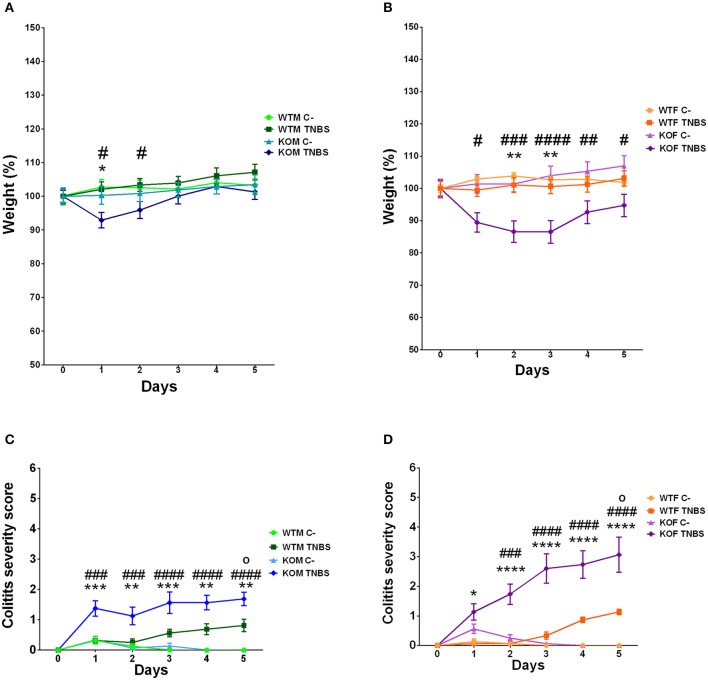
Body weight evolution and clinical assessment of colitis in mice during the 5 days of procedure. Males (A) and females (B) were weighed daily. Abrogation of AM results in a significant weight loss among TNBS-treated mice, which is higher among females. Colitis symptoms were evaluated on a 0–12 point scale in males (C) and females (D). TNBS-treated KO animals showed more severe disease symptoms reaching higher final scores than their treated WT littermates. (A–D) Data are shown as mean ± SEM. (A–D) Two way ANOVA + Tukey's MCT. Asterisks represent statistically significant differences between TNBS-treated KO versus TNBS-treated WT mice; *p < 0.05. **p < 0.01. ***p < 0.001. ****p < 0.0001. Pound signs represent statistically significant differences between TNBS-treated KO vs. vehicle-treated KO mice; #p < 0.05. ##p < 0.01. ###p < 0.001. ####p < 0.0001. Symbol ° represents statistically significant differences between TNBS-treated WT vs. vehicle-treated WT mice; °p < 0.05. WTM, male wild type mice; WTF, female wild type mice; KOM, male knockout mice; KOF, female knockout mice.